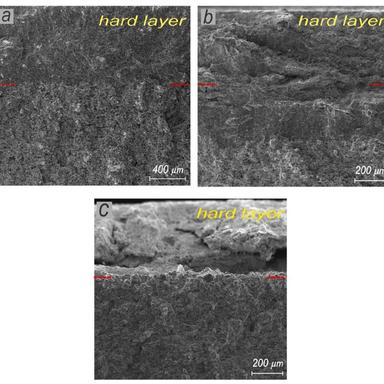
SEM images of the fractured surfaces of n0.1 gradient specimens after bending from a) iron surface, b) hard surface and c) Charpy impacted from the hard surface.